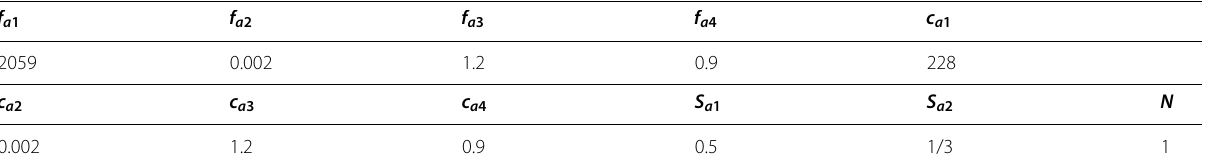
Table 1 Model parameters of the sintered steel Astaloy 85 Mo for the modified Abouaf model